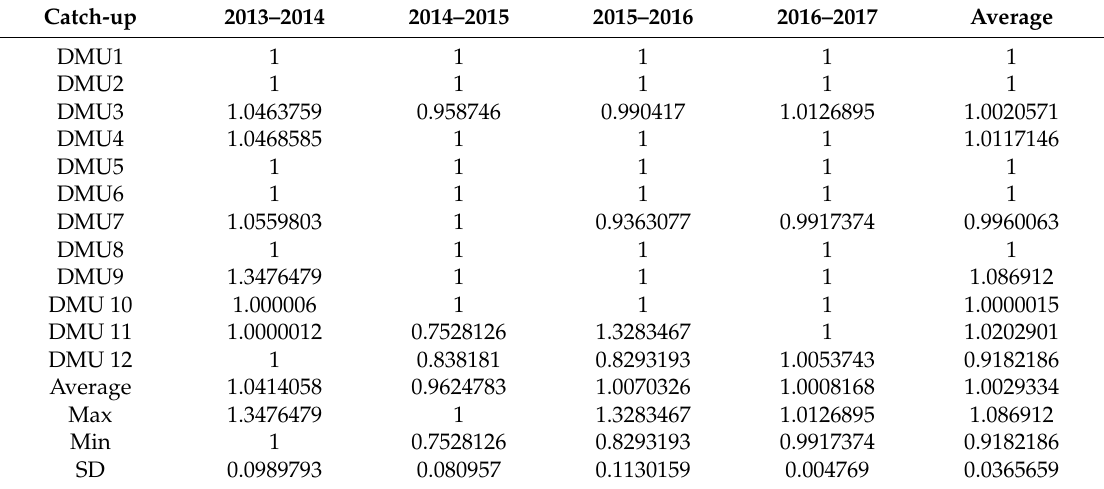
Table 7. Efficiency (catch-up) change over the period from 2013 to 2017.